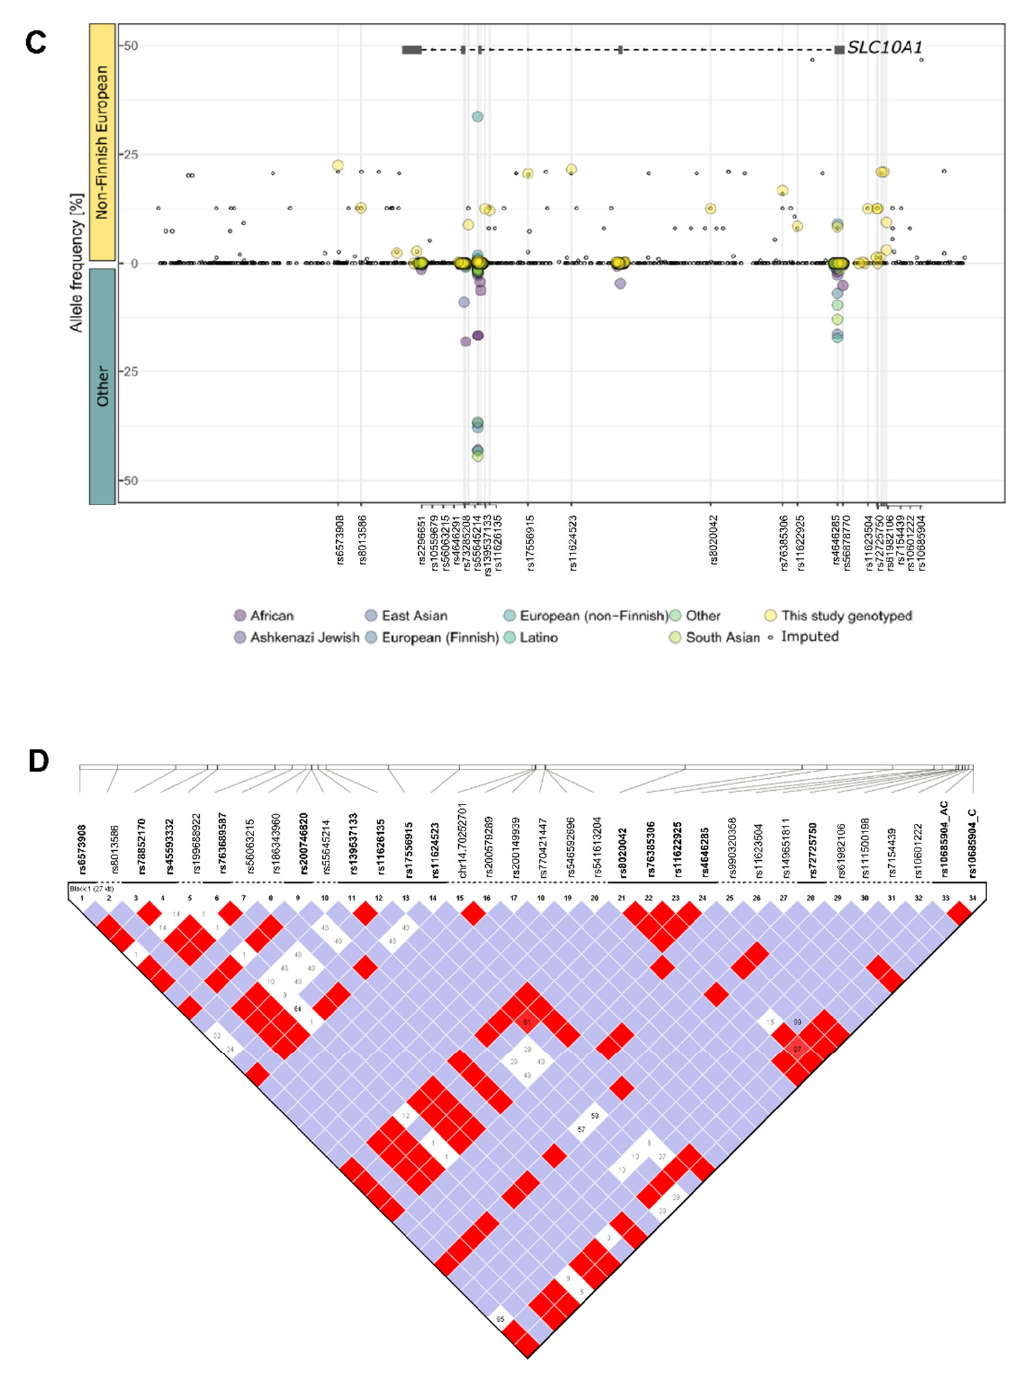
Figure 1. Expression and genetic variability of SLC10A1 /NTCP in human liver. ( A ) Hepatic SLC10A1 mRNA expression in 143 individuals. Results are presented as histogram, including cumulative frequencies. mRNA levels were measured using qPCR. ( B ) Hepatic NTCP protein levels in 143 individuals, which was analyzed by targeted proteomics using mass spectrometry. Results are presented as histogram, including cumulative frequencies. ( C ) Schematic overview of the SLC10A1 locus (hg19: chr.14:70242135-70264007) with all analyzed (genotyped as well as imputed) SNPs in the 143 liver samples in relation to Genome Aggregation Database (gnomAD) data (gno- mAD_v2.1_ENSG00000100652_2019_03_+UTR; data accessed in March 2019). On the top panel minor allele frequencies (MAF) greater than zero of variants detected in samples with European ancestry are shown. On the lower panel MAFs available in samples with other ethical backgrounds are shown on a reverse y-scale. Common variants (MAF > 5%) are highlighted using vertical gray lines and rs numbers. While yellow points are showing variants genotyped with NGS, MALDI-TOF MS, or Sanger sequencing, small black points are illustrating SNPs that have been imputed from global SNP array information on the same liver subjects (Infinium Global Screening Array GSA